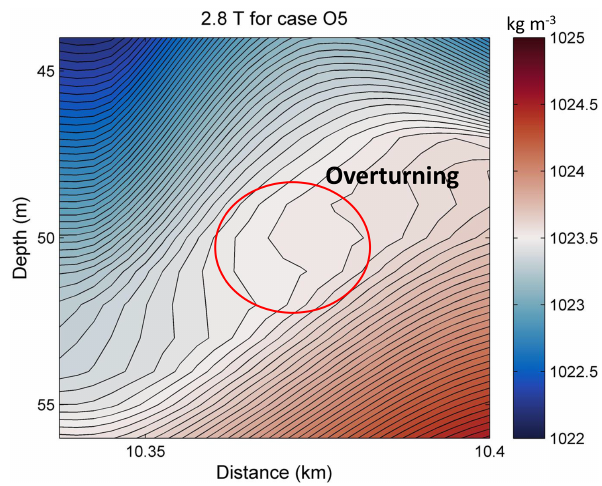
Figure 18. The density contour plot at 2.8 T for case